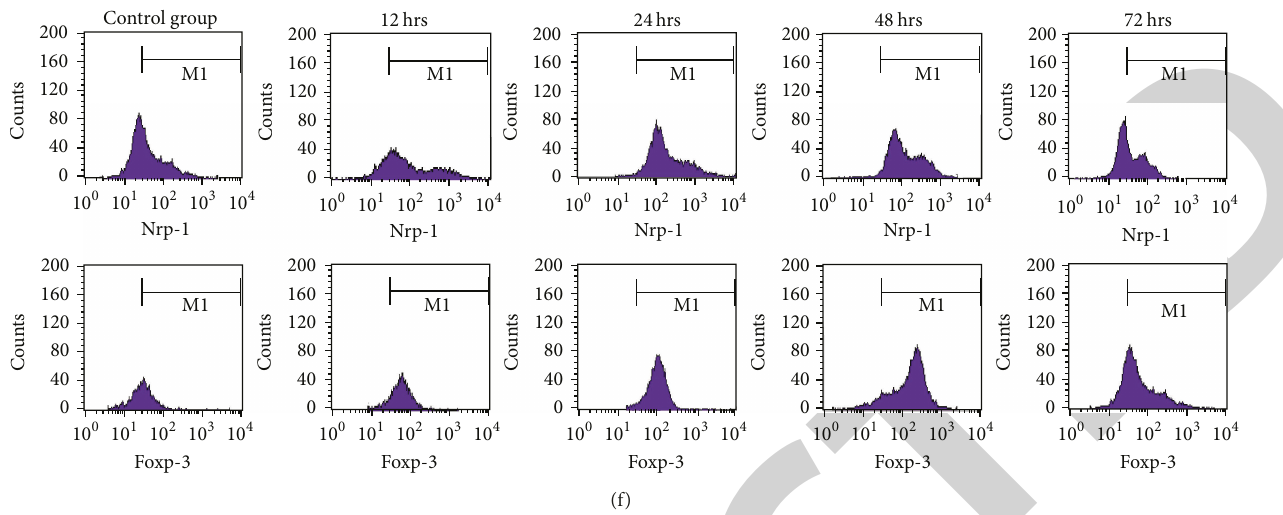
Figure 1: The grade- and time-dependent responses between sepsis and the expression of Nrp-1 in splenic CD 4 + CD 25 + Tregs. The results showed the effects of various severities of sepsis on the expression of Nrp-1 in splenic CD 4 + CD 25 + Tregs at 24 hours after CLP ((a), (e)). The grade-dependent impact between sepsis and the 24-hour survival rate (b). The effects of midgrade sepsis on the expression of Nrp-1 of splenic CD 4 + CD 25 + Tregs at 12, 24, 48, and 72 hours after CLP ((c), (f)). The time-dependent response between sepsis and the 72-hour survival rate (d). Data was represented as mean ± standard deviation (SD) and analyzed by SPSS 17.0 software with a one-way ANOVA, 𝑛 = 4 per group ( 𝑃 < 0.01 ). The survival rate was analyzed by Kaplan-Meier via the log-rank test, 𝑛 = 30 per group ( 𝑃 < 0.05 or 𝑃 < 0.01 ).